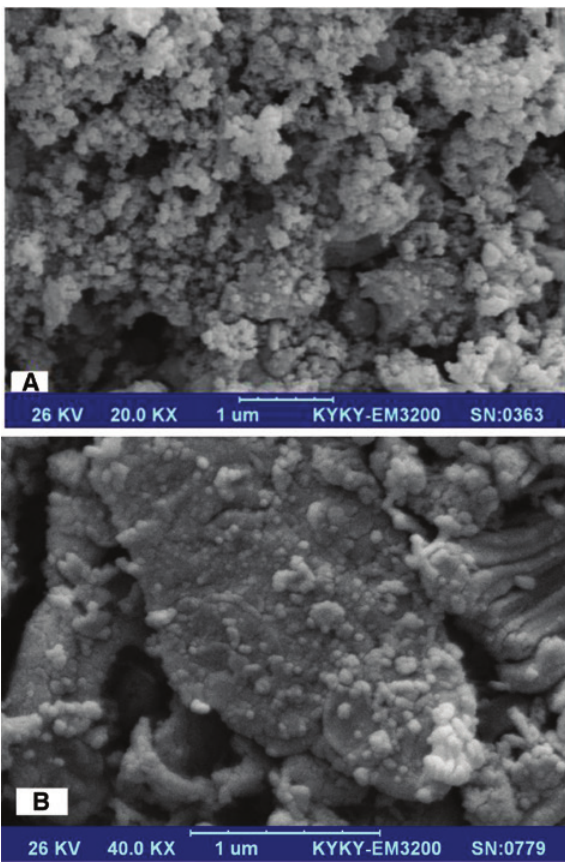
H. Figure 3: Low angle XRD patterns of (A) FSM-16 and (B) FSM-16-SO 3